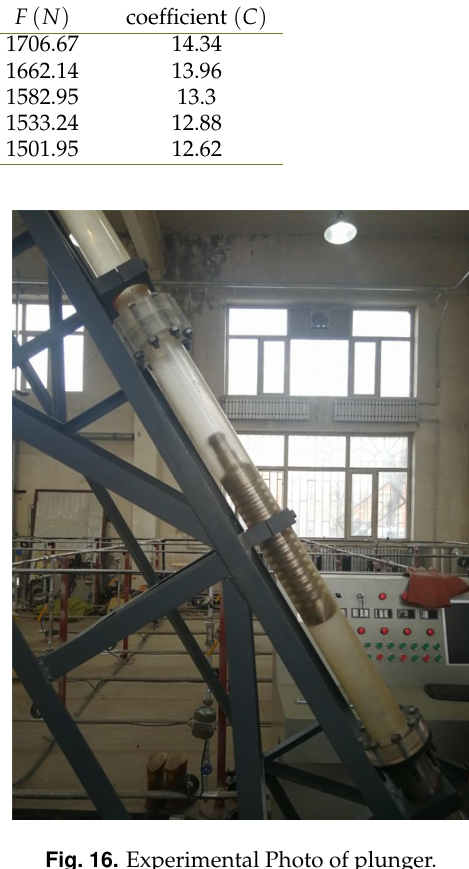
Fig. 16. Experimental Photo of